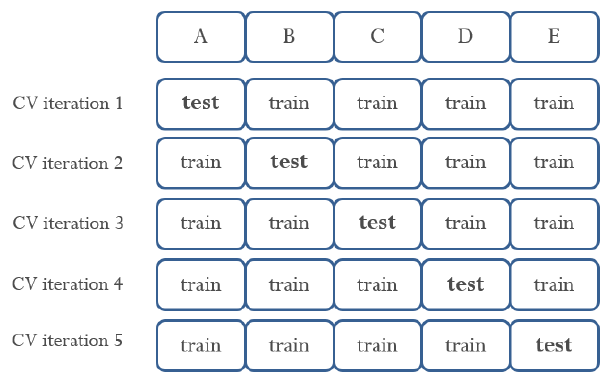
Figure 5. 5-fold cross-validation data segmentation.